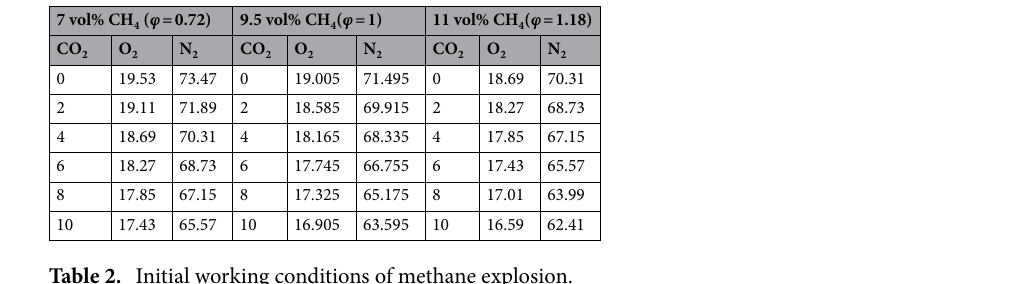
Table 2. Initial working conditions of methane